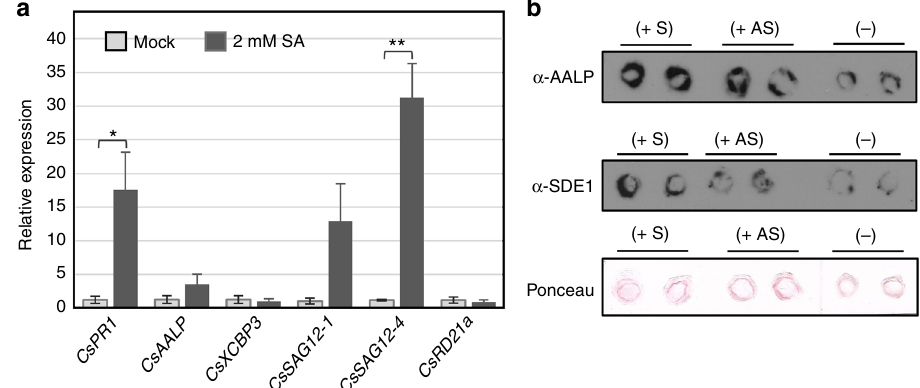
Fig. 3 Cs PLCPs accumulate during SA treatment and infection. a Abundance of PLCP genes was determined by quantitative RT-PCR after SA treatment. One-year-old Navel oranges ( C . sinensis ) were sprayed with 2 mM SA or water. Leaf samples were collected after 48 h for RNA extraction and PCR analyses. Cytochrome oxidase subunit 1 ( COX , KF933043.1) was used as the internal standard. Graph shows mean ± standard error of three replicates. Asterisks (*) indicate statistically signi fi cant differences based on the two-tailed Student ’ s t -test. p < 0.05 = *, p < 0.01 = **. b Protein abundance of PLCPs was determined in healthy ( − ) or C Las-infected ( + ) citrus branches using an anti-AALP antibody. Freshly cut stems were stamped onto nitrocellulose membranes and PLCPs and SDE1 were detected using western blotting. The titer of C Las in each sample was evaluated by quantitative PCR with observed Ct values of 27.97 for symptomatic tissue ( + S), and not detected for asymptomatic tissue from the same infected tree ( + AS) or tissue from an uninfected tree ( − ). Ponceau-stained membrane was shown as a